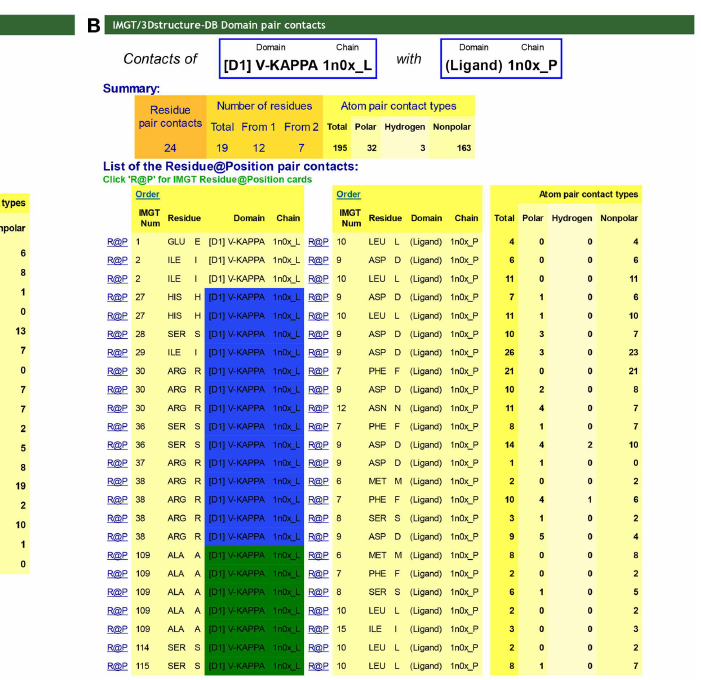
FIGURE 6 | IMGT/3Dstructure-DB Domain pair contacts betweenVH andV-KAPPA and the ligand from an IG/Ag complex .The IG/Ag complex structure is 1n0x from IMGT/3Dstructure-DB (http://www.imgt.org) (11–13). The ligand is a synthetic peptide. (A) Domain pair contacts betweenVH and the ligand.The Summary shows that there are a total of 106 atom pair contacts (10 polar including 1 hydrogen bond and 96 non-polar) for 17 pair contacts between theVH (1n0x_H) and the ligand (1n0x_P). Seven amino acids (AA) of theVH interact with the ligand.The list of the pair contacts show that three of them belong to the CDR2-IMGT (orange color online) and two of them to the CDR3-IMGT (purple color online), and together contribute to 81 atom pair contacts (including the hydrogen bond).TheVH binds the ligand primarily by the N64 of the CDR2-IMGT and the P112.3 and Q112.2 of the CDR3-IMGT that are localized next to the top of the loops